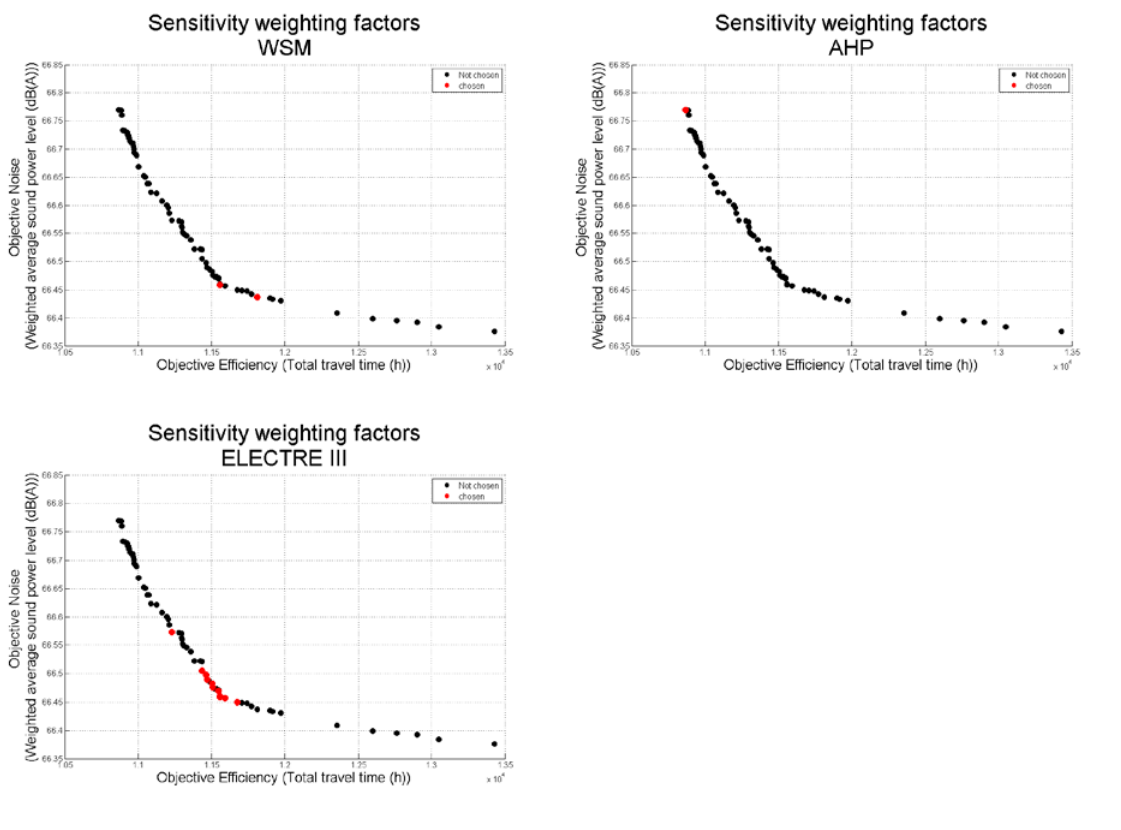
Figure 4. Differences in chosen solutions per method Analysis of the sensitivity of the methods for the weighting factors shows that the ELECTRE III method is most sensitive to the weighting factors. One of the reasons is that WSM and AHP only will find best solutions that are part of the convex hull. WSM is slightly more sensitive than AHP, which is due to the difference in normalization used in these methods. Figure 5 shows the chosen solutions based on a sensitivity analysis in which the weighting factors for two objectives can range between 1 and 2 (i.e. the weight of one objective can be twice as high as the other).